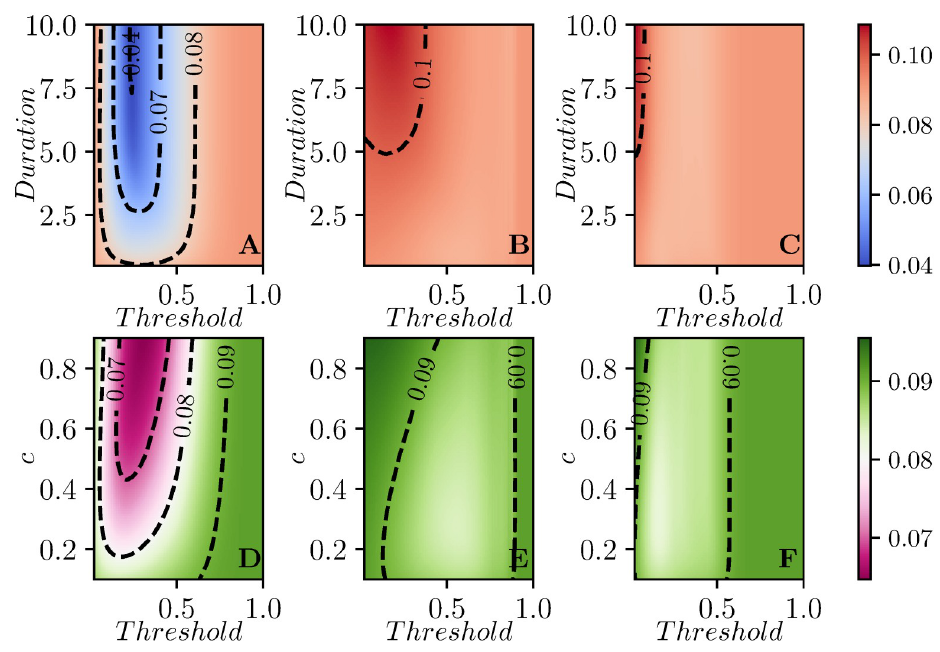
(cid:0) � P ð t Þ , averaged across 100 simulated populations 1 = max I peak t i i 9